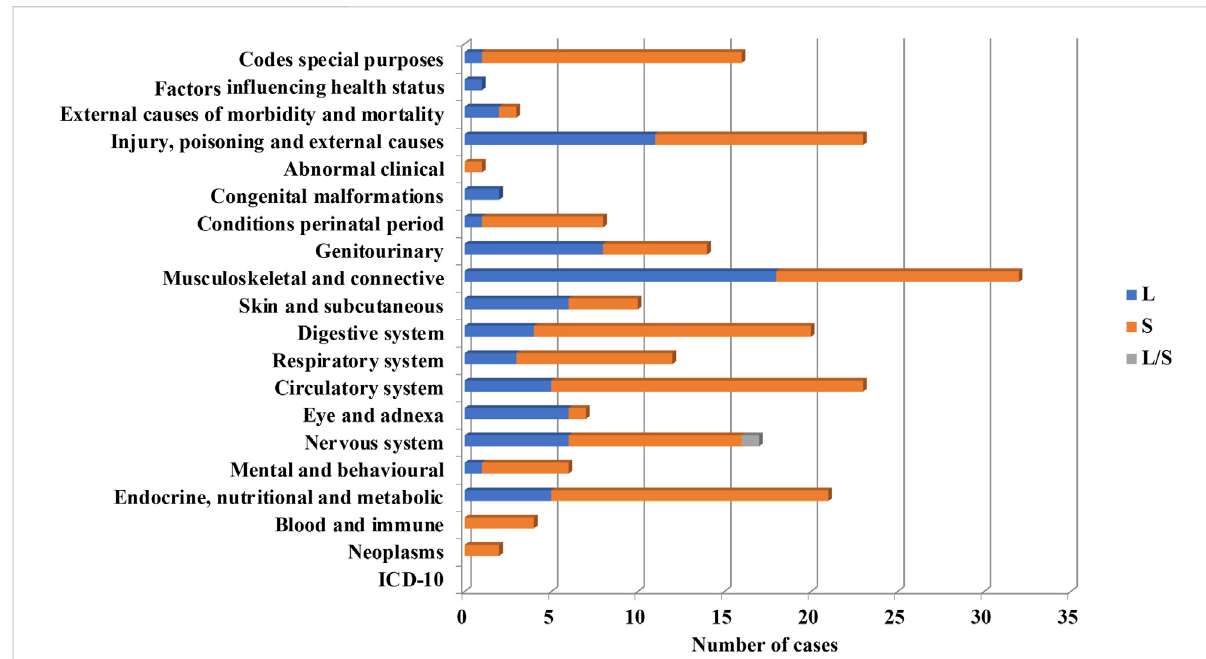
FIGURE 7 Systemic (S) or local (L) use of PnD cell products for the indication of different